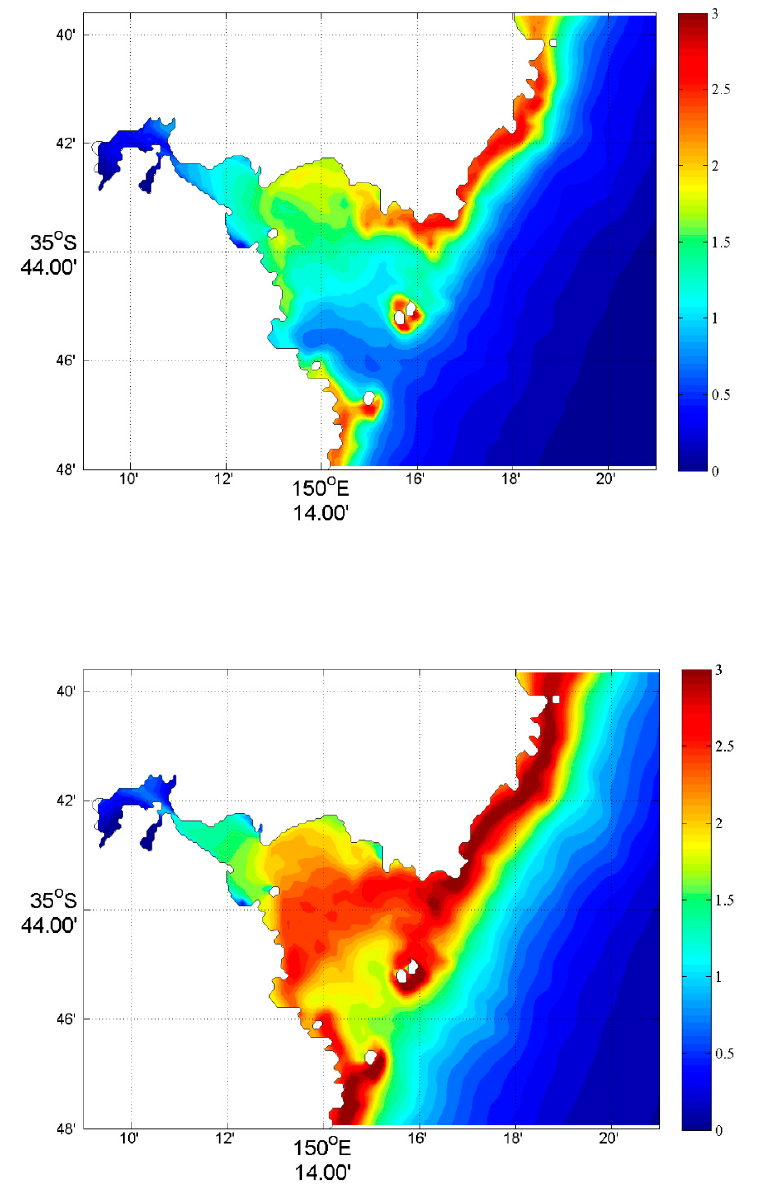
Figure 7. Model-predicted wave-induced bottom stress for prevailing south-westerly winter winds ( top ) and prevailing south-easterly summer winds ( bottom ), with a constant storm wind speed of 25.7 m/s.